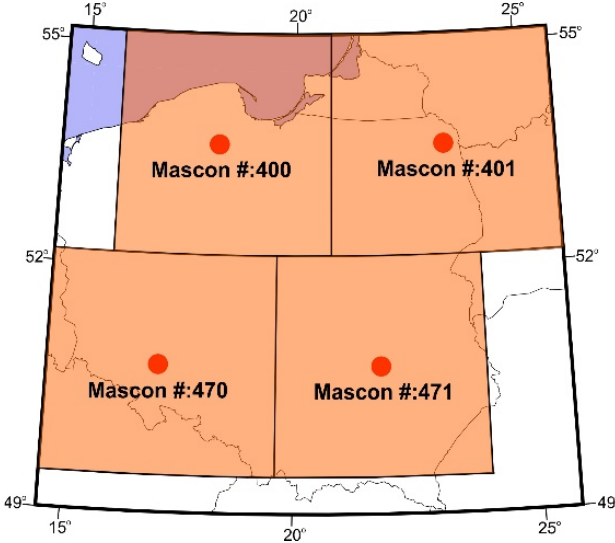
Figure 4. The locations of mascons over Poland.